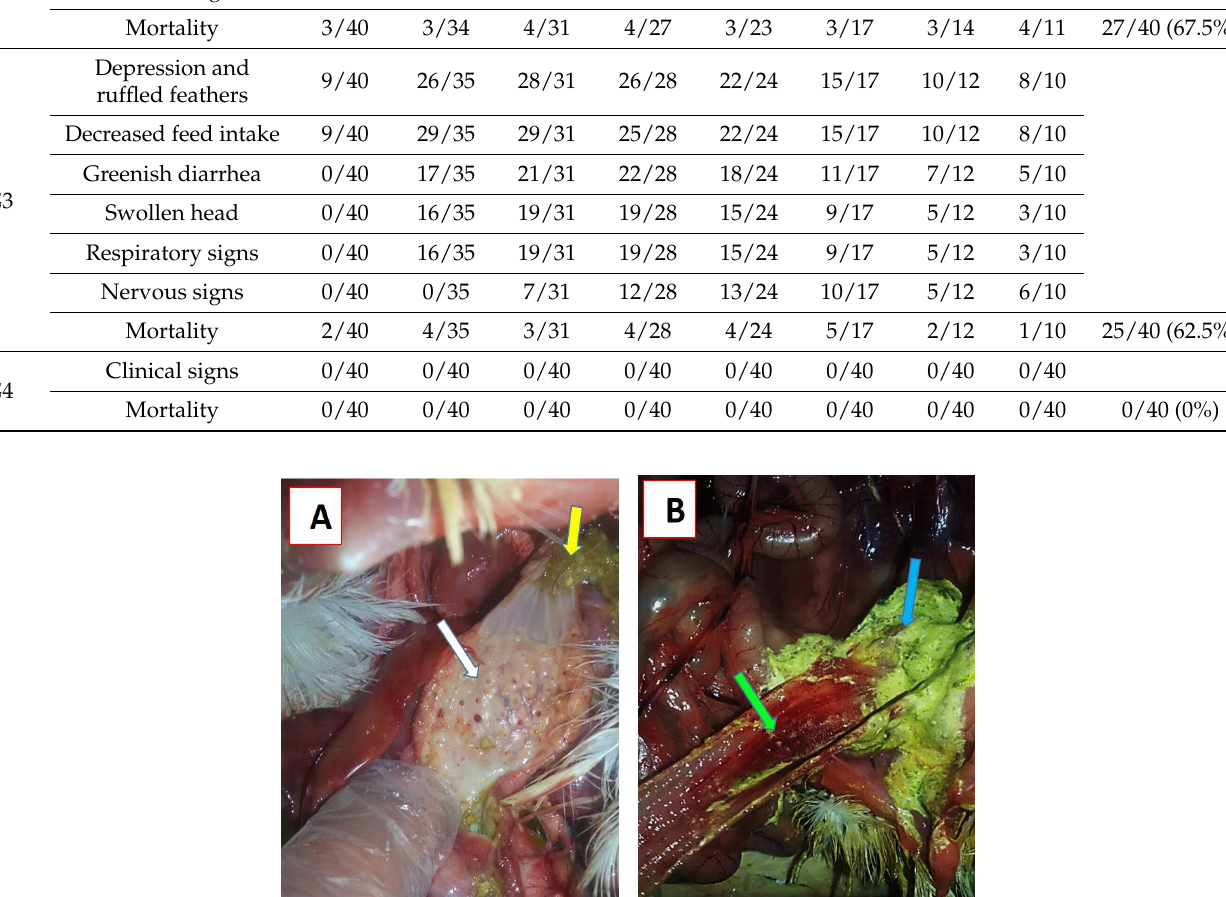
Figure 6. Post-mortem changes in experimentally infected chickens: ( A ) hemorrhages on the tips of proventricular glands (white arrow) and greenish proventricular contents (yellow arrow); ( B ) greenish intestinal contents (blue arrow) and hemorrhagic enteritis (green arrow).